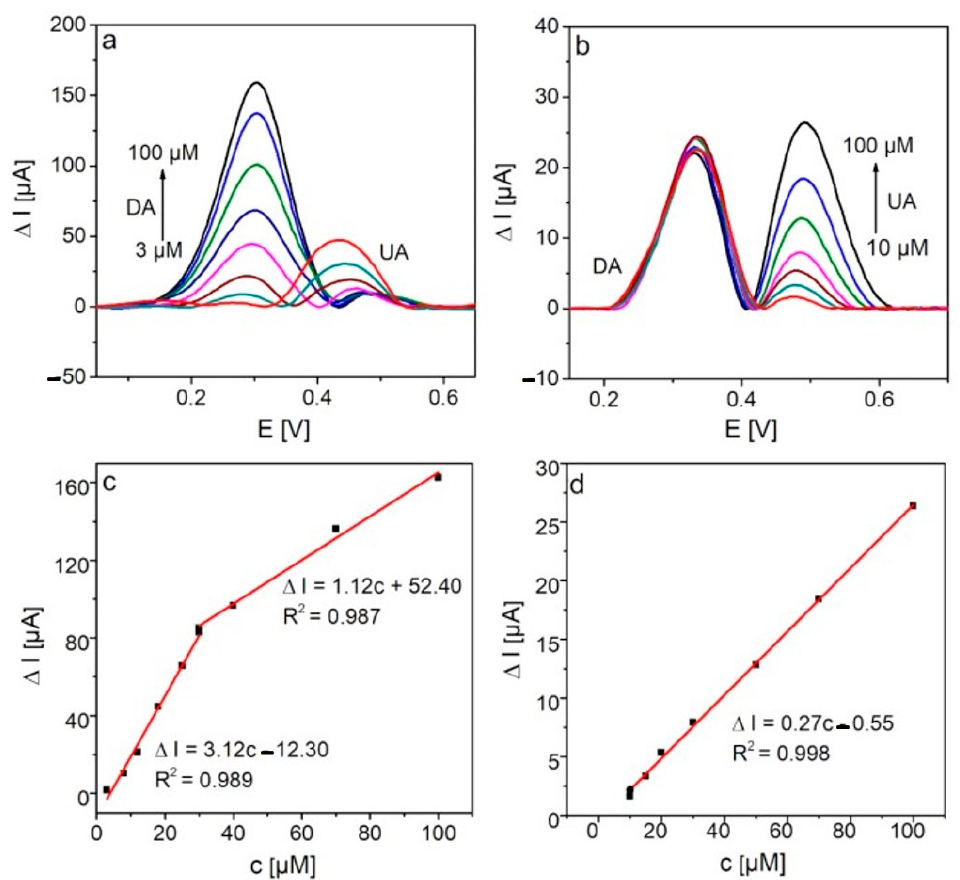
Figure 7. DPV curves recorded on the GCE/PFSG electrode in ( a ) 0.1 M PBS (7.0) containing 100 µM UA and different concentrations of DA and ( b ) 0.1 M PBS (6.6) containing 50 µM DA and different concentrations of UA. Calibration plots of ( c ) DA and ( d ) UA.